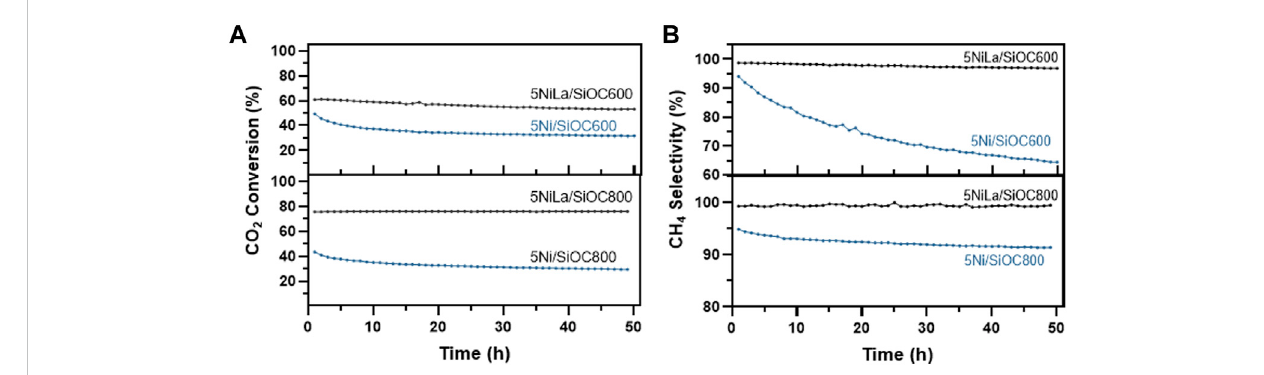
CO 2 conversion (A) and CH 4 selectivity (B) of catalysts with and without La-modi fi cation over the course of 50 h at 400 °